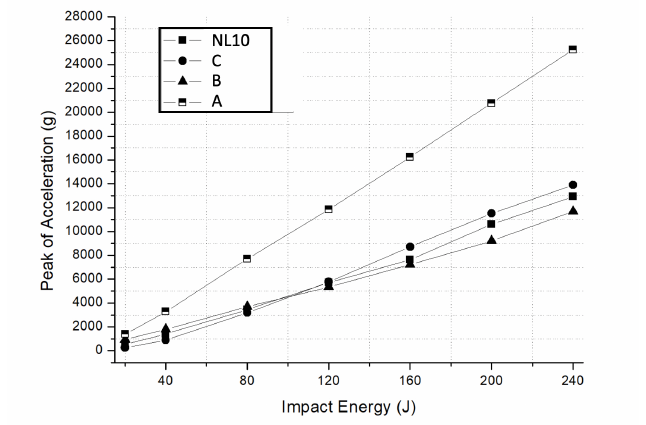
Figure 10. Peak Linear Acceleration (PLA) results for each material in the headform impact